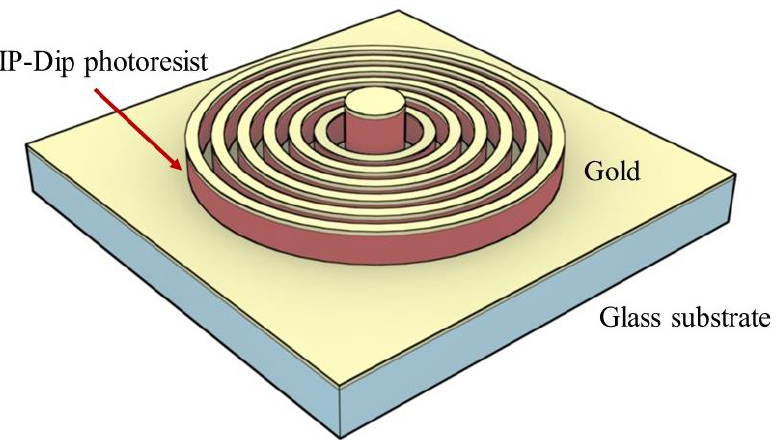
Figure 1. Schematic view of designed gold-IP-Dip MRZ structure on the glass substrate.